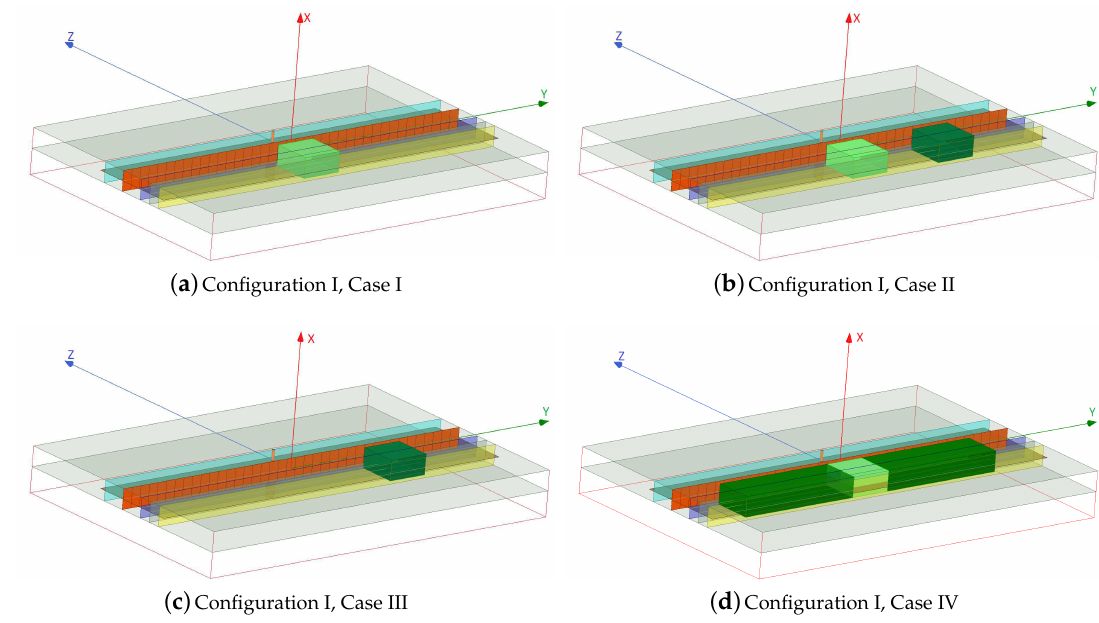
Figure A1. Summary of different case studies under Configuration I of the NF plate setup.